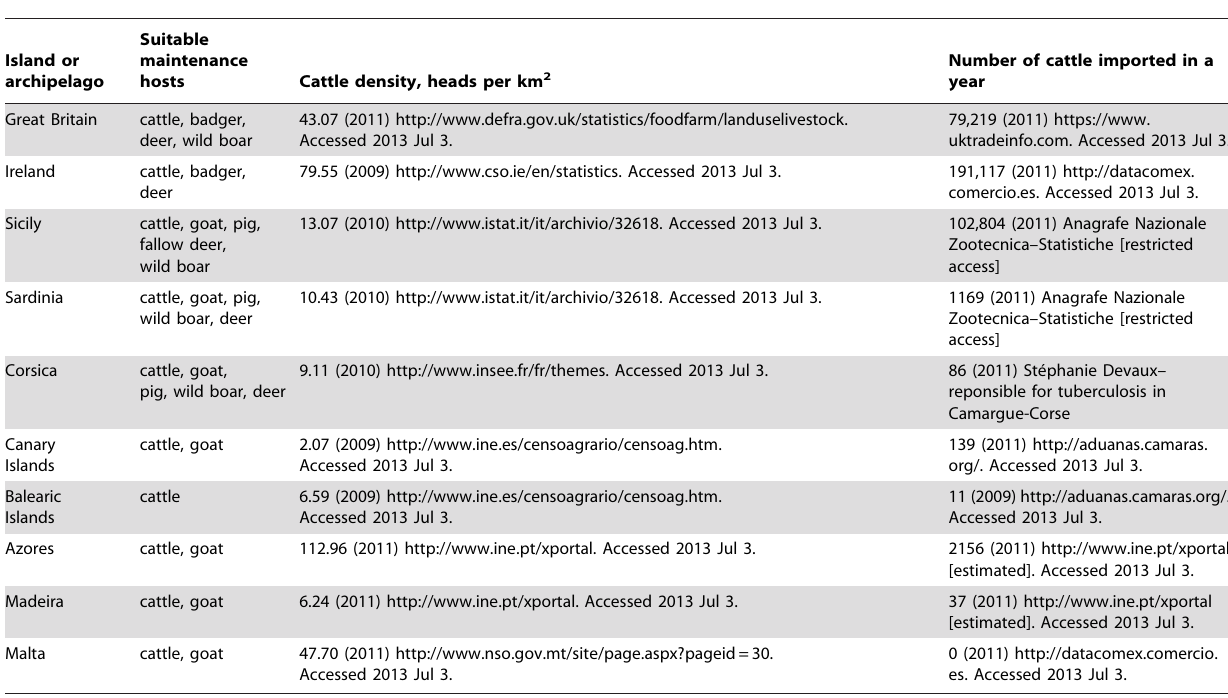
Table 2. Data used for modelling purposes, the year to which the data refers (between brackets) and the source of the information (see text for